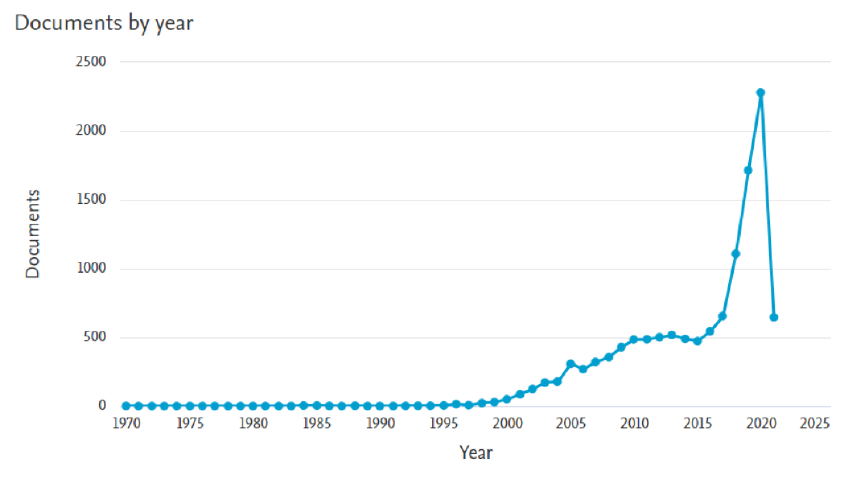
Figure 1. Search Results from Scopus, from 1970 to 2021 for the keywords “chatbot” or “conversational agents” or “conversation